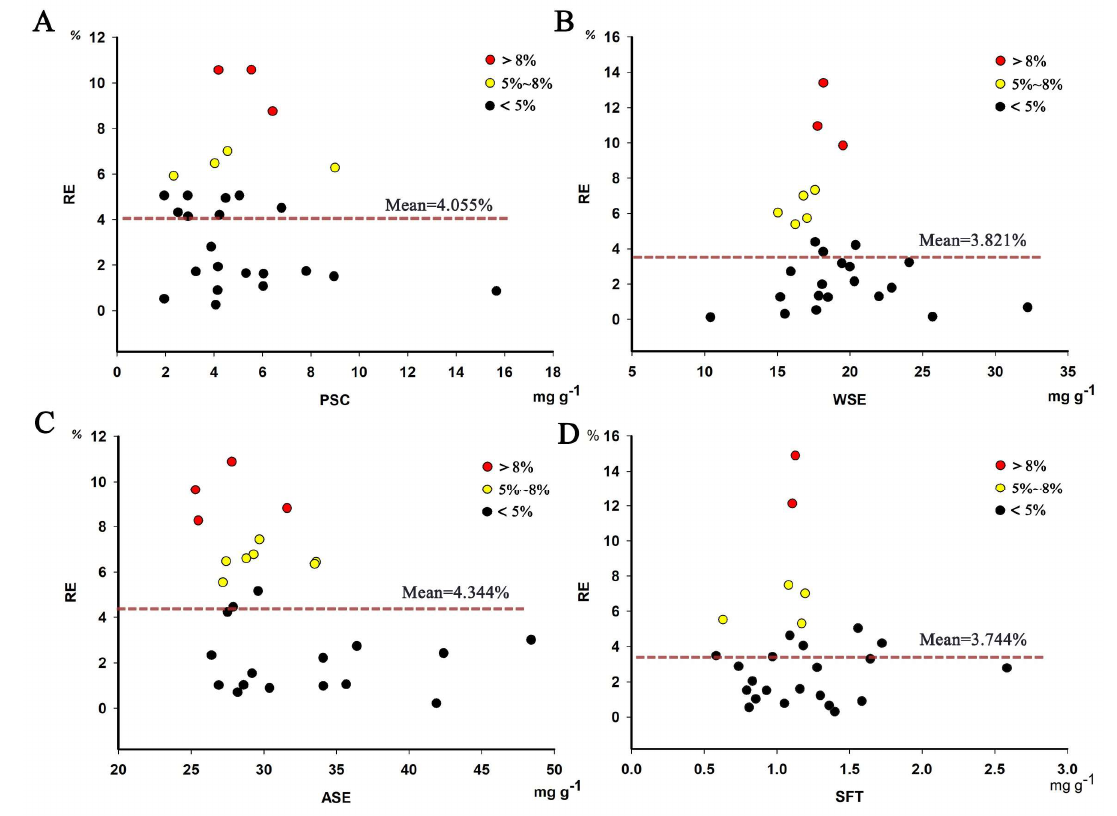
Figure 5. The relative error (RE) of polysaccharides (PSC), water-soluble extract (WSE), alcohol- soluble extract (ASE) and sum of five triterpenoids (SFT). ( A ) polysaccharides; ( B ) water-soluble extract; ( C ) alcohol-soluble extract; ( D ) sum of five